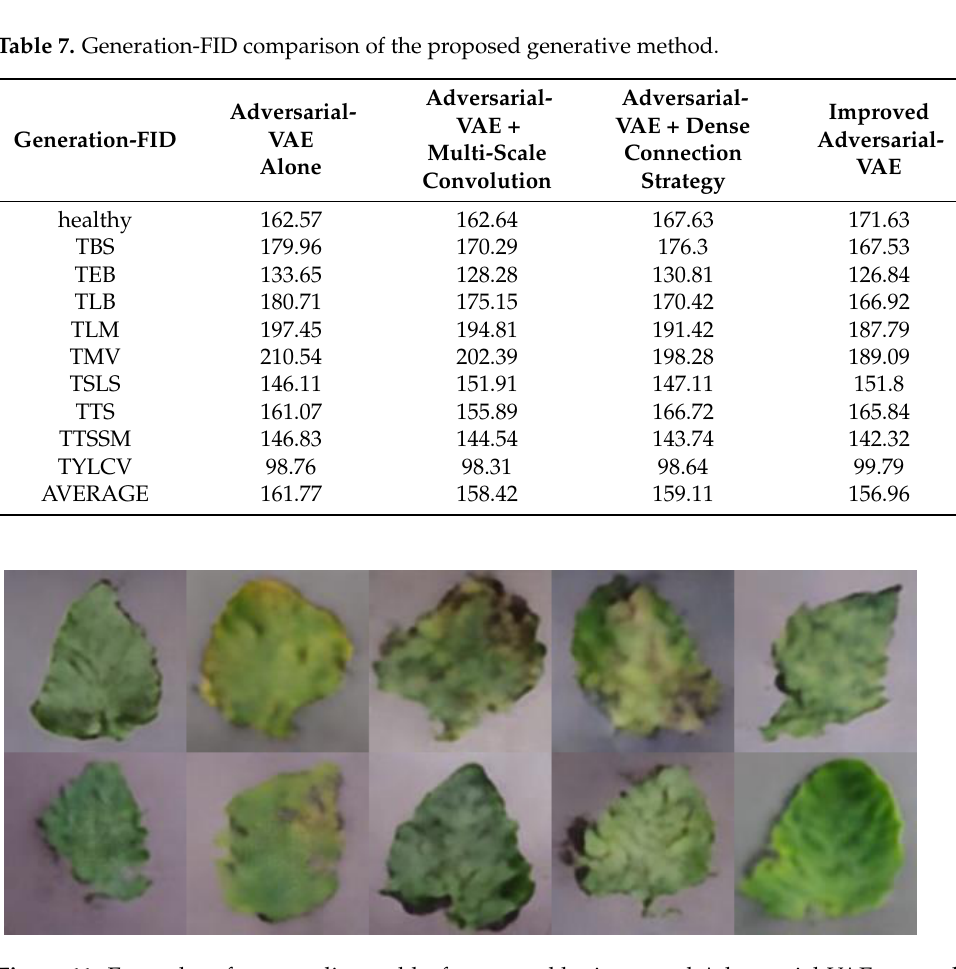
Figure 12. Examples of tomato diseased leaf generated by VAE networks: healthy, TBS, TEB, TLB, TLM, TMV, TSLS, TTS, TTSSM, and TYLCV, respectively. 4.2. Identification Results and Analysis The original training set contains 10,892 images. After using improved Adversarial- VAE, the training set is expanded to 21,784 images. For comparative experiments, the original data set is expanded twice by replication, namely 21,784 images. Three experi- ments are carried out to train the classification network as shown in Figure 13 to identify tomato leaf diseases. During the operation, the training set and the test set are divided into batches by batch training. The batch training method is used to divide the training